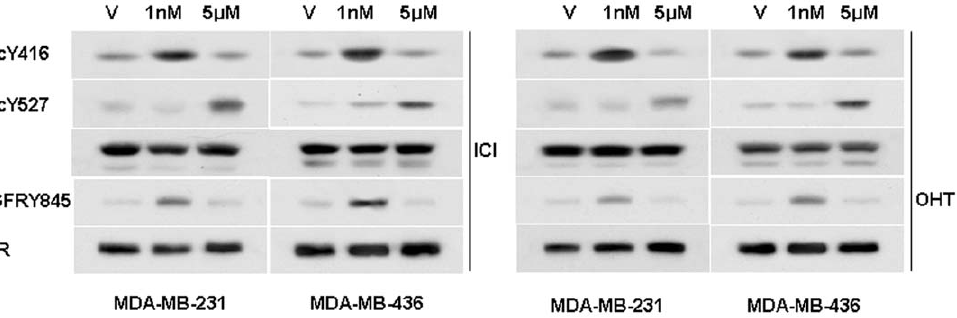
Figure 2. Different concentrations of antiestrogens induce Src phosphorylation at distinct residues. Western blot analysis of the effects of different concentrations of antiestrogens on the phosphorylation levels of EGFR-Y845, Src-Y416 and Src-Y527 in MDA-MB-231 and MDA-MB-436 cells.